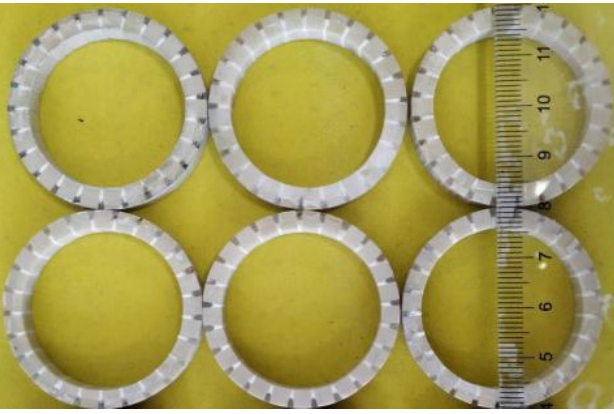
Figure 7. Three-phase piezoelectric composite single ring.